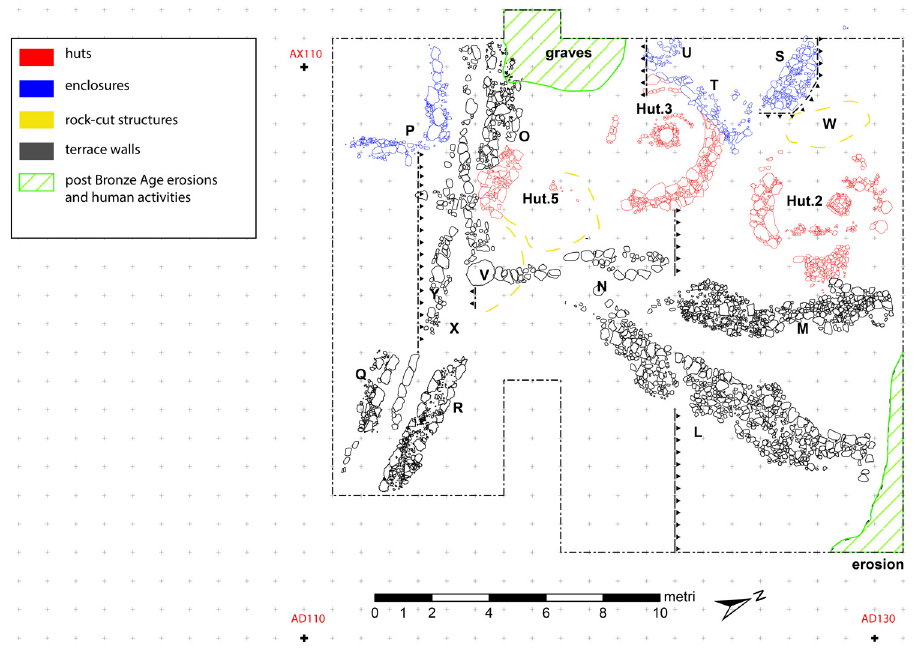
Figure 5. Western area: the main structures and the 1x1 m topographical grid (A. Di Renzoni, L. Lopes, D.